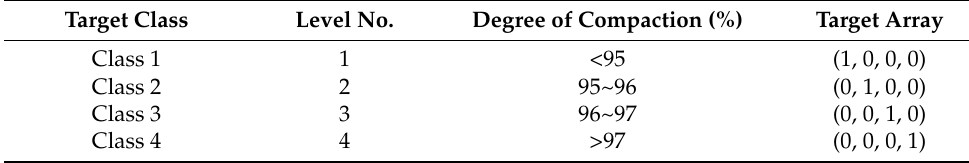
Table 2. Target class and compaction